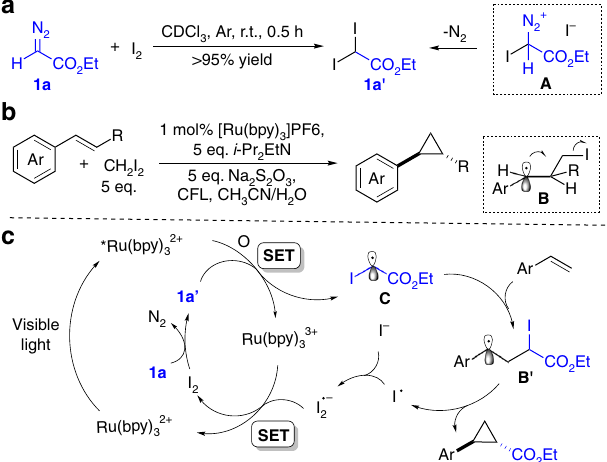
Fig. 2 Synthesis of diiodoacetate 1a ′ and our hypothesis. a Rapid reaction between diazo 1a and I 2 . b Ole fi n cyclopropanation via photo-initiated CH 2 I 2 activation reported by Suero. c Our proposal: combining iodine